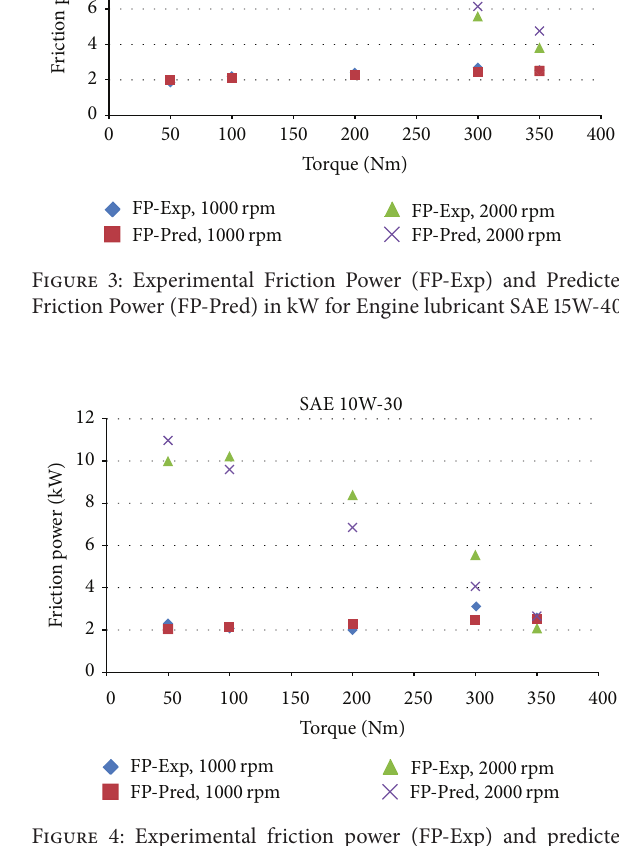
Figure 4: Experimental friction power (FP-Exp) and predicted friction power (FP-Pred) in kW for engine lubricant SAE